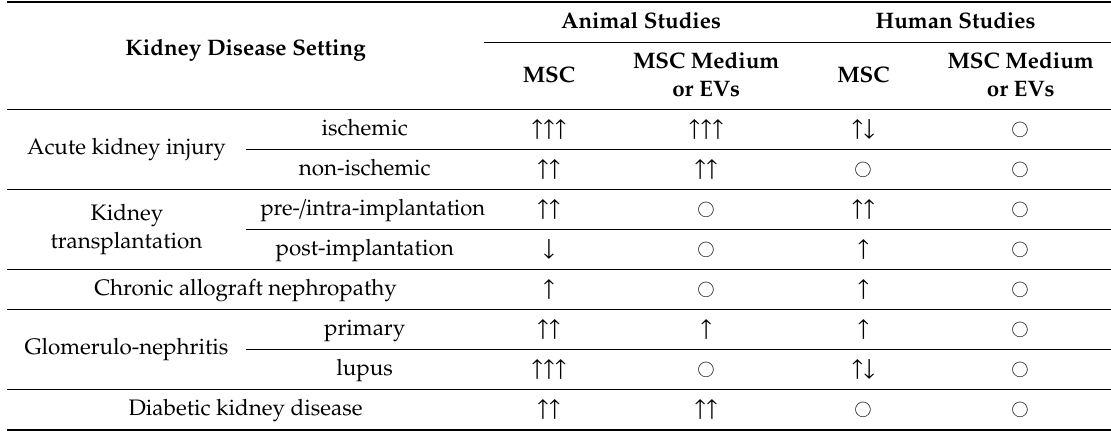
Animal Studies Human Studies MSC Medium MSC Medium MSC MSC or EVs or EVs